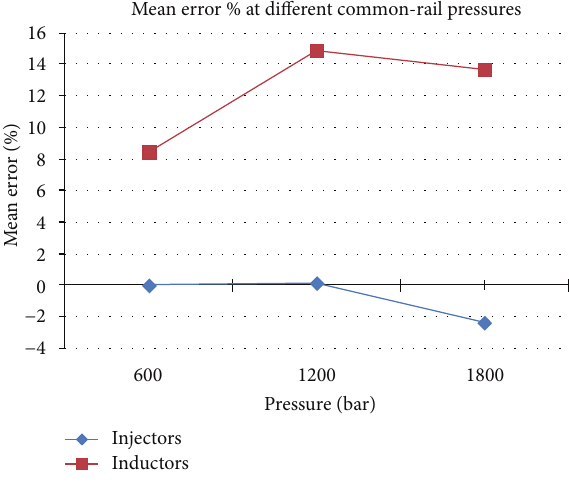
Figure 8: Comparing error % against bar pressure for injectors and inductors.